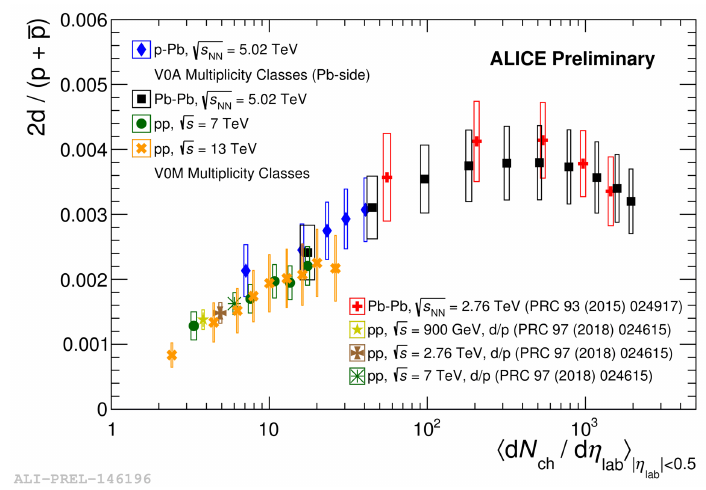
Figure 3. Ratio between the deuteron and proton yields as a function of the event